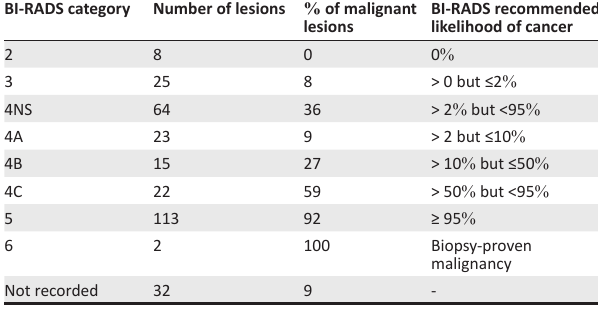
TABLE 4: Distribution of the number of ultrasound-guided core-needle breast biopsy lesions in each BI-RADS category with a comparison of the percentage of malignant lesions in category with the BI-RADS recommendations.